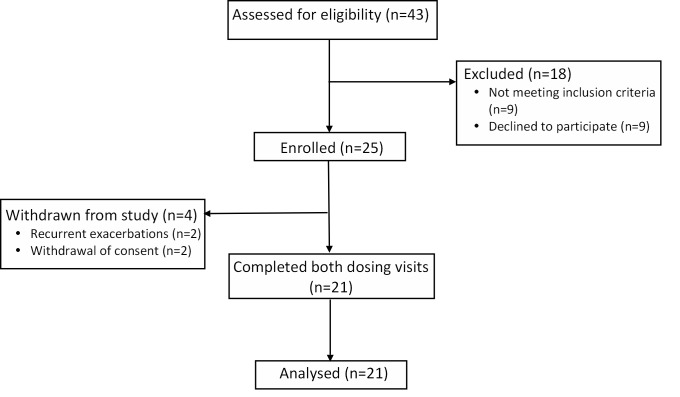
CONSORT recruitment diagram for enrolment and study completion.